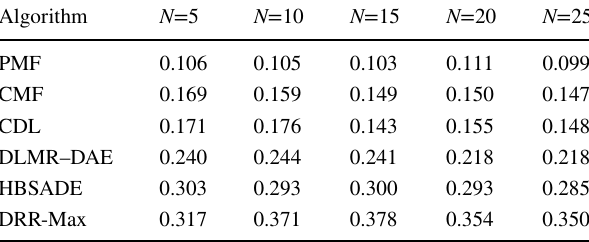
Table 5 F1 for Book-crossing data set Algorithm